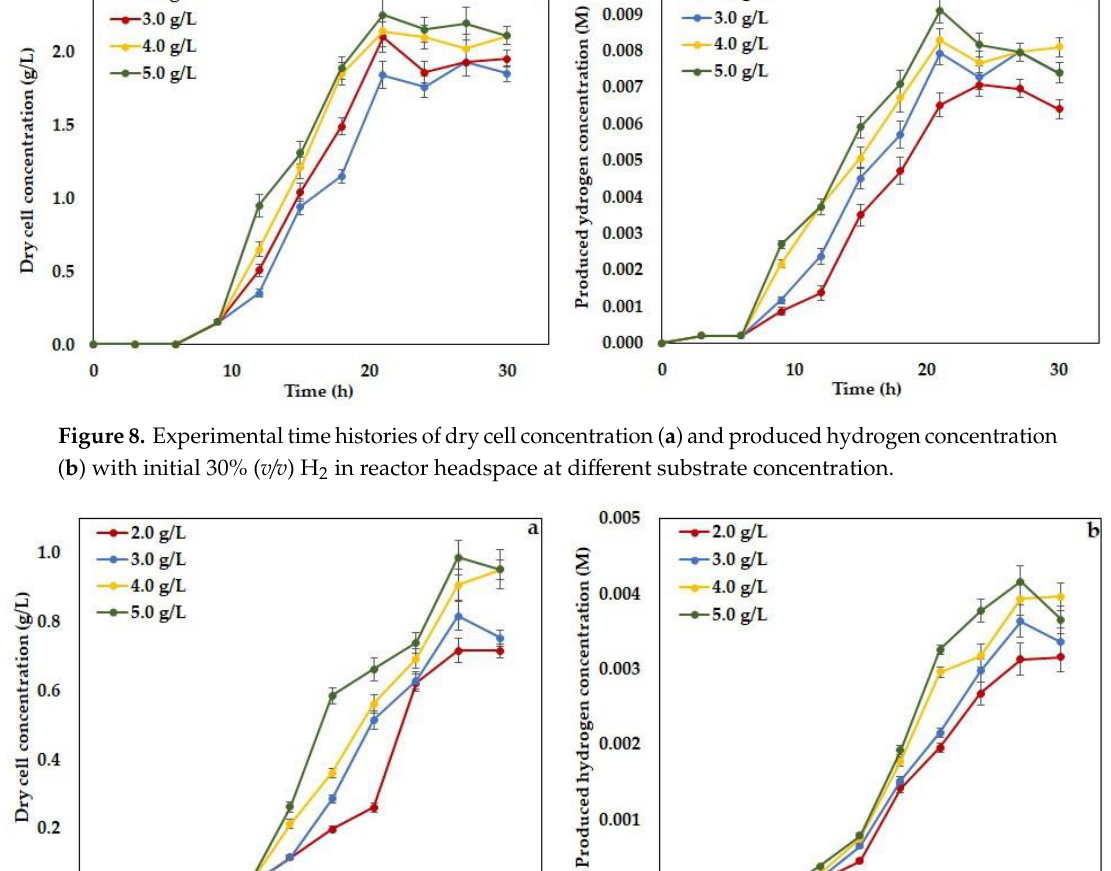
Figure 9. Experimental time histories of dry cell concentration ( a ) and hydrogen concentration ( b ) with initial 40% H 2 in reactor headspace at different substrate concentration.